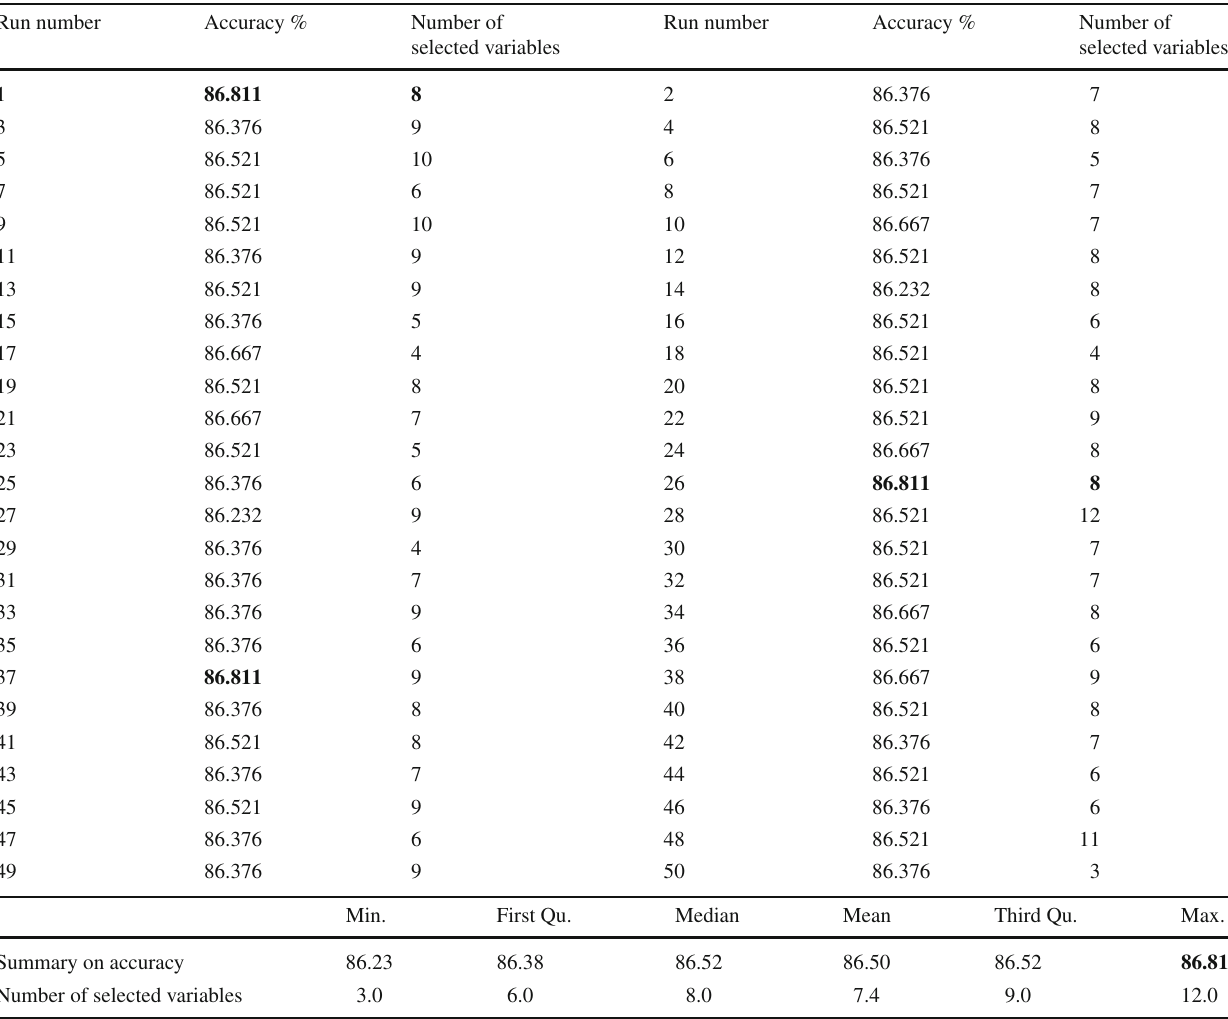
Table 8 The results of 50 run of VNS+SVM on Australian dataset Run